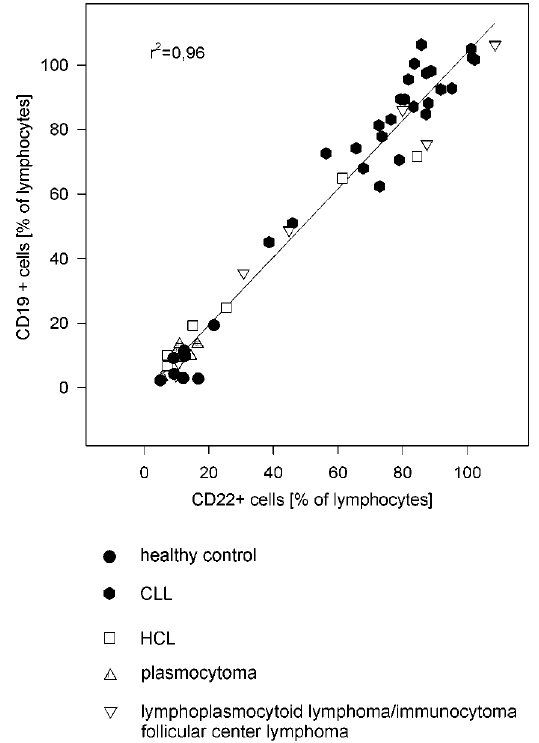
Fig. 2. Correlation between independently calculated B-cell popula- tions (CD19 + versus CD22 + cells) as % of lymphocytes. The good correlation between the independent determinations proves accuracy of staining and cluster analysis.